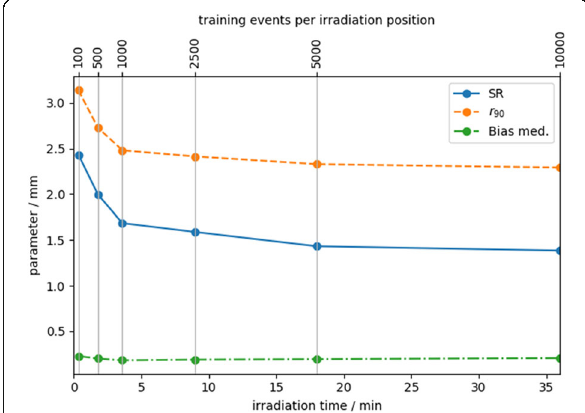
Fig. 1 (abstract A11). Performance parameter against training events per irradiation position (upper x-axis) and irradiation time (lower x-axis) for one calibration direction. Training data of 0.75 mm pitch were used. SR and r 90 were averaged over the whole crystal. The data usage of the GTB models was not restricted during the training. All models required less than 2 MB memory